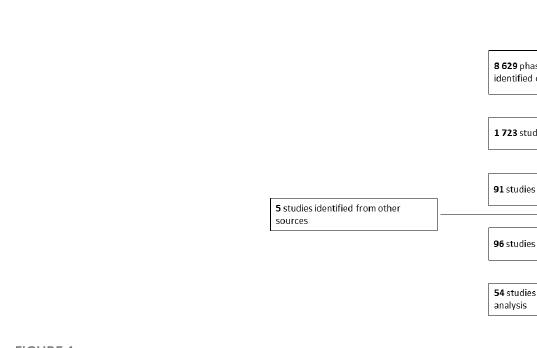
FIGURE 1 Selection process of the studies used in